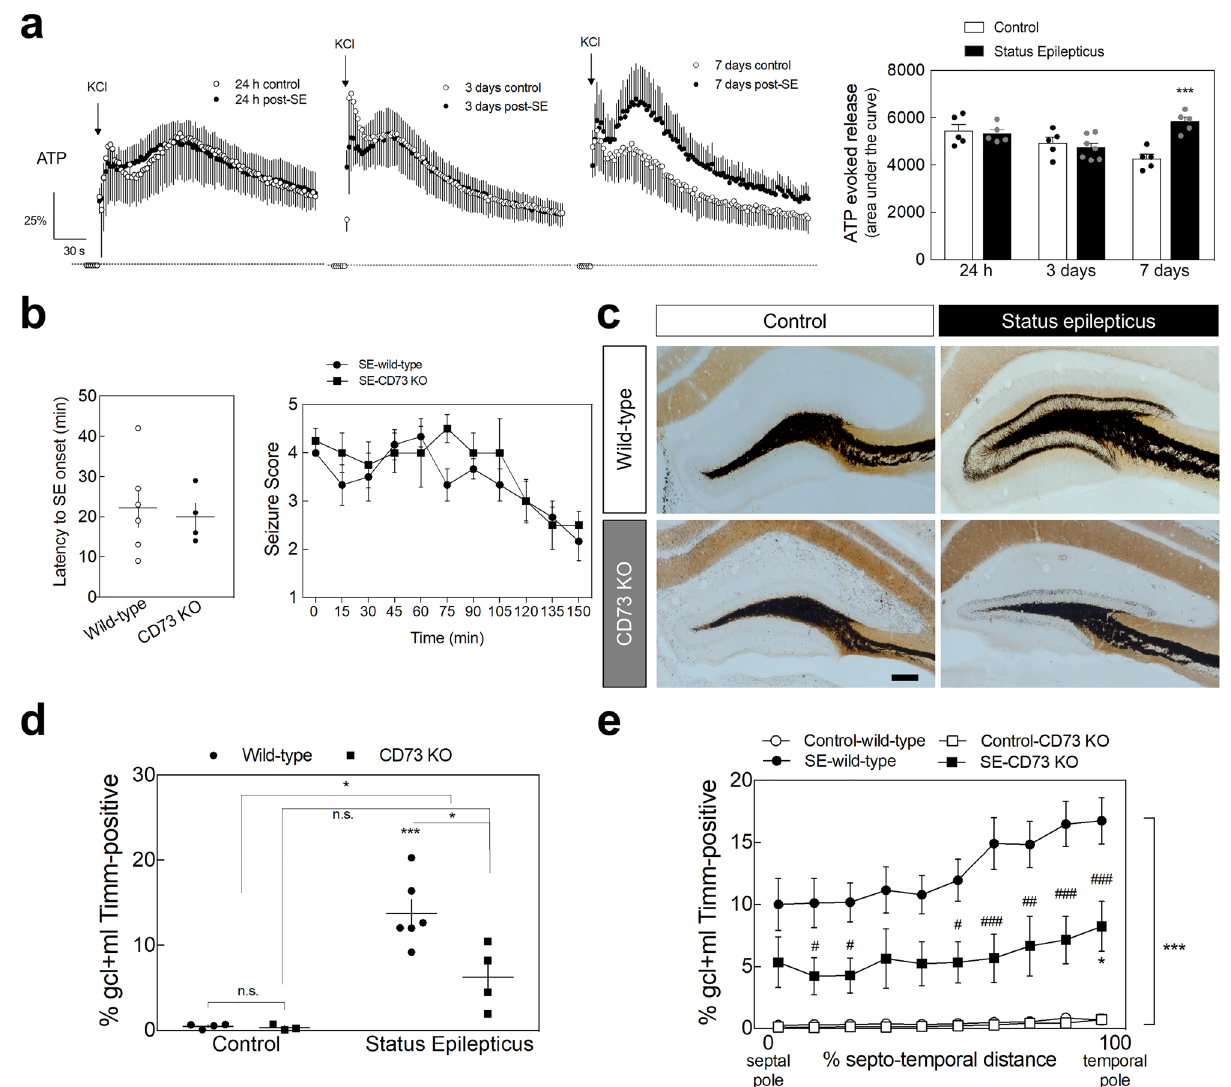
Figure 6. ATP-derived adenosine contributes to status epilepticus-induced hippocampal mossy fiber sprouting. ( a ) The evoked presynaptic release of ATP induced by a K + -induced depolarization (KCl 30 mM) of purified hippocampal nerve terminals prepared from animals that experienced status epilepticus (SE) was analyzed at 24 h, 3 days and 7 days upon SE induction. Only animals reaching at least stage 4 seizures were considered. Convulsions were suppressed with diazepam (10 mg/kg, i.p. ) 2 h after the occurrence of the first stage 4 seizure. While at 24 h and 3 days after SE induction, it was not observed any significant differences, the evoked release of ATP from hippocampal synaptosomes prepared 7 days after SE was significantly higher vs. control rats. Data are mean ± SEM of the percentage of modification in extracellular levels of ATP (time-course graphs) or of the area under the curve (histogram). Control (24 h), n = 5; SE (24 h), n = 5; Control (3 days), n = 5; SE (3 days), n = 7; Control (7 days), n = 5; SE (7 days), n = 5. The data are mean ± SEM of the percentage of modification in extracellular levels of ATP relative to basal levels. *** P < 0.001, one-way ANOVA with Sidak’s test. ( b ) Latency onset and seizure score during SE of wild-type mice and CD73-KO mice. Data are mean ± SEM. ( c ) Wild-type mice that had experienced SE displayed a dense Timm staining in the inner molecular layer of the dentate gyrus 105 days later, whereas in CD73-KO mice SE induced a significantly lower Timm staining, as depicted in the representative images (scale bar, 300µm) and quantitatively summarized in the ( d ) upper histogram. ( e ) The lower SE-induced mossy fiber sprouting in CD73-KO mice was observed along the entire septotemporal axis of the DG. The data are mean ± SEM of the percentage of the granule cell layer (GCL) plus molecular layer (ML) that displayed Timm staining. Control-wild-type, n = 4; Control-CD73 KO, n = 3; SE-wild-type, n = 6; SE-CD73 KO, n = 4. * P < 0.05 and *** P < 0.001 for SE vs. Control either in wild-type or in CD73-KO mice; # P < 0.05, ## P < 0.01, ### P < 0.001 for CD73-KO vs. wild-type mice either experiencing SE or not; two-way ANOVA with Sidak’s